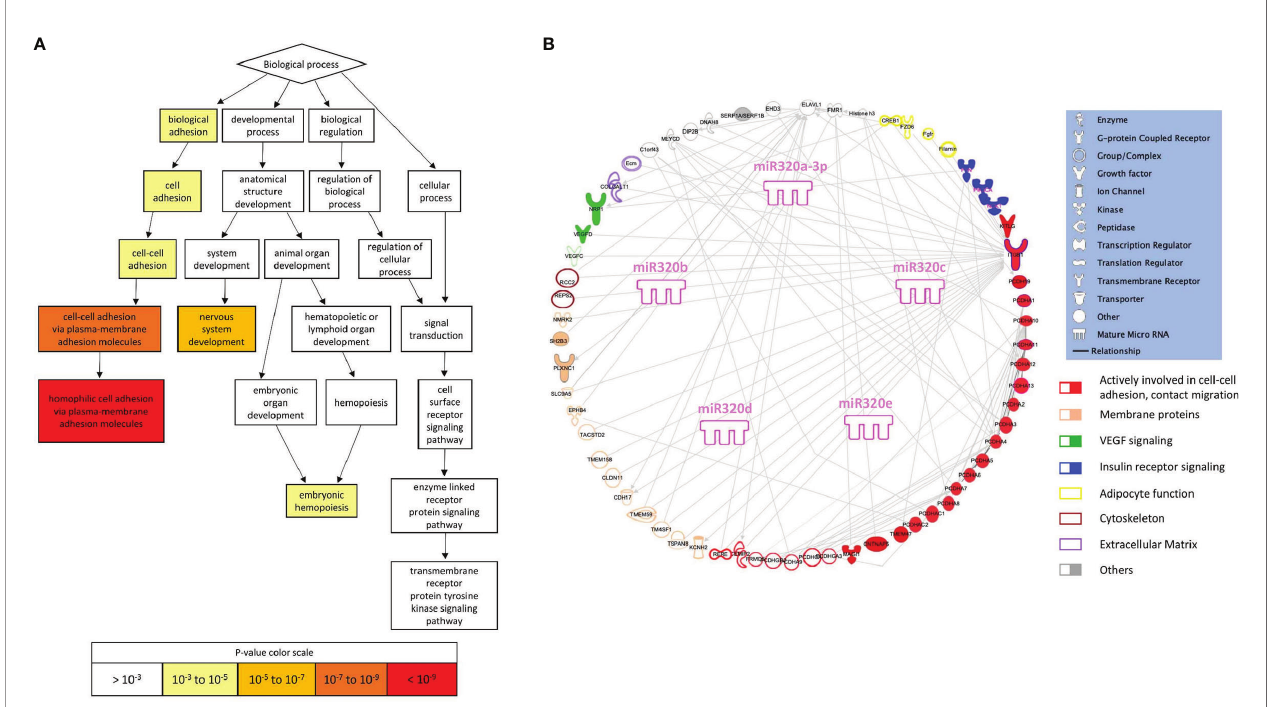
FIGURE 4 | Gene ontology and pathway analysis. (A) Visualization of enriched GO terms for a ranked list of 320 miRNA targets (from the publicly available platform GOrilla). The white to red scale indicates progressively increased signi fi cance of the enrichment. (B) Graphical representation of the network generated by the proteins included in the enriched GO terms (elaborated using IPA, Qiagen, Hilden,